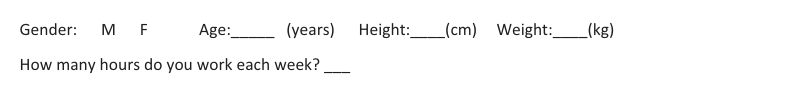
Table: Please answer by puŒng an "X" in the appropriate box - one "X" for each ques(cid:13)on. You may be in doubt as to how to answer, but please do your best anyway. Note that column 1 of the ques(cid:13)onnaire is to be answered even if you have never had trouble in any part of your body; columns 2 and 3 are to be answered if you answered yes in column